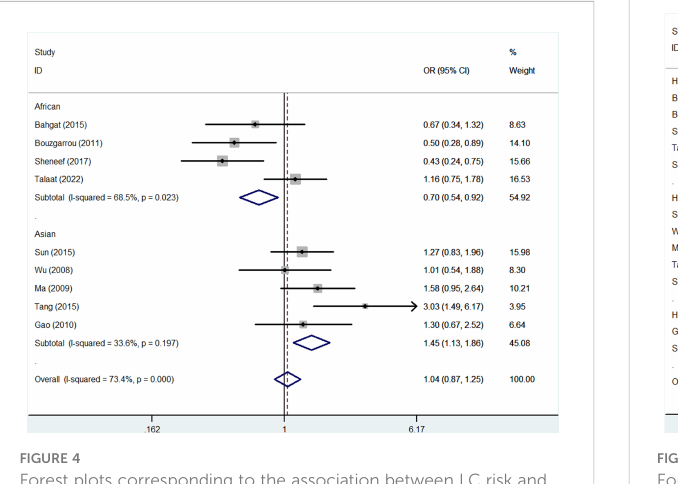
FIGURE 5 Forest plots corresponding to the association between LC risk and rs2430561 polymorphisms in different LC subgroups generated using an allelic contrast